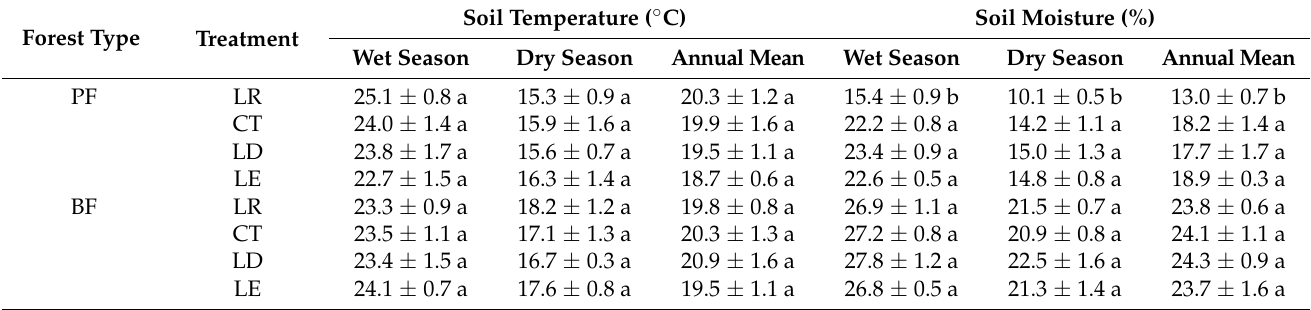
Table 2. Soil temperature (0–5 cm) and moisture (0–10 cm) in PF (Masson pine forest) and BF (evergreen broadleaved forest) exposed to different litter manipulation treatments from August 2012 to July 2013. Data are shown by mean ± se. Different lowercase letters indicate significant differences between treatments in each forest ( p < 0.05). LR = litter removal; CT = control; LD = litter doubling; LE = litter